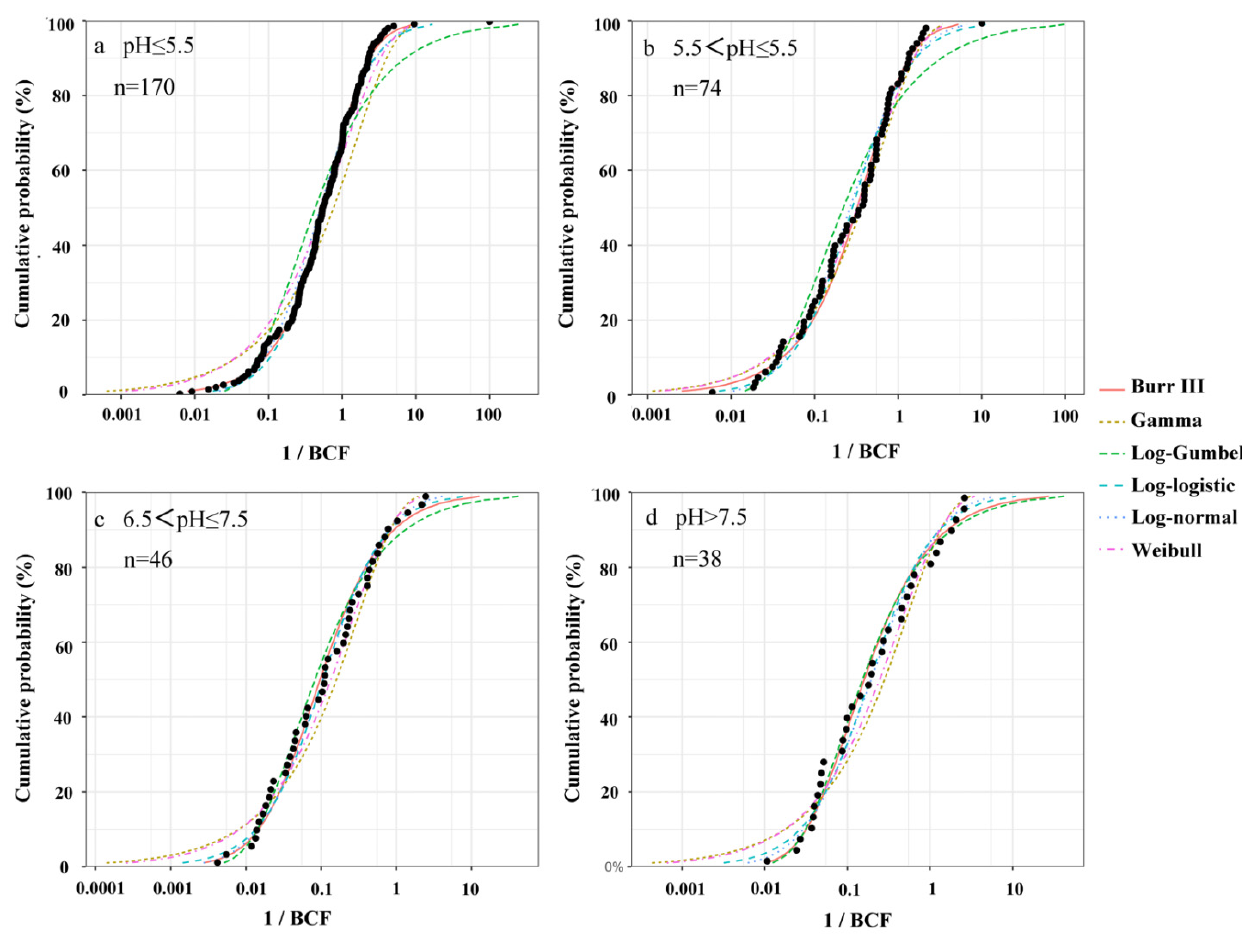
Figure 6. Species sensitivity distribution of rice grains for accumulating Cd according to different soil pH ranges.